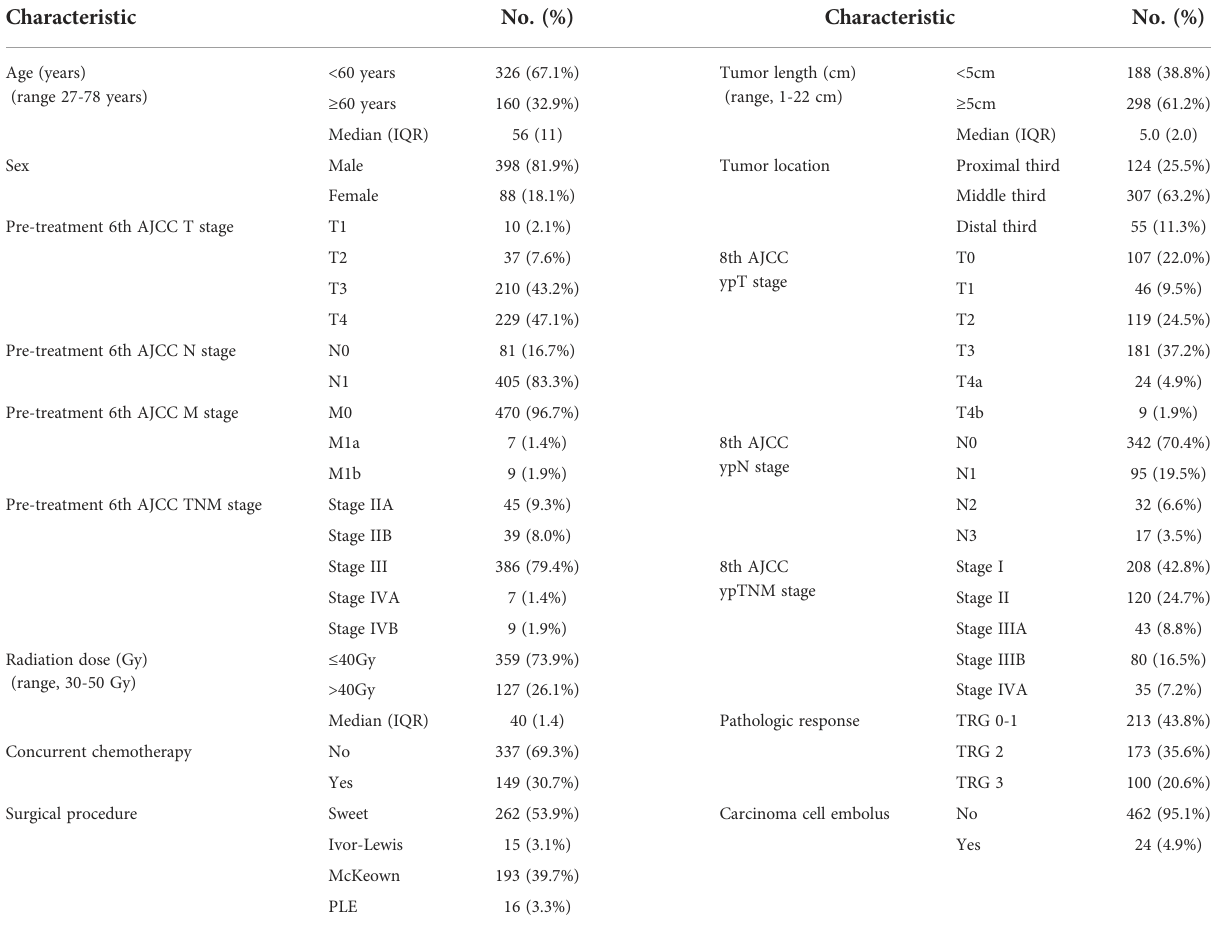
TABLE 1 Baseline